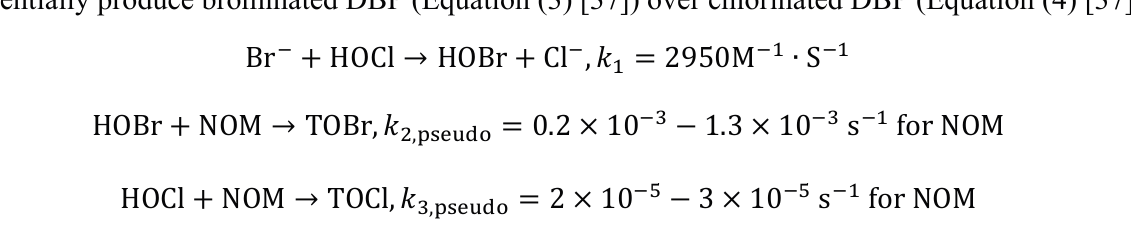
, catalytic ozonation alone; O + Bio., 3 3